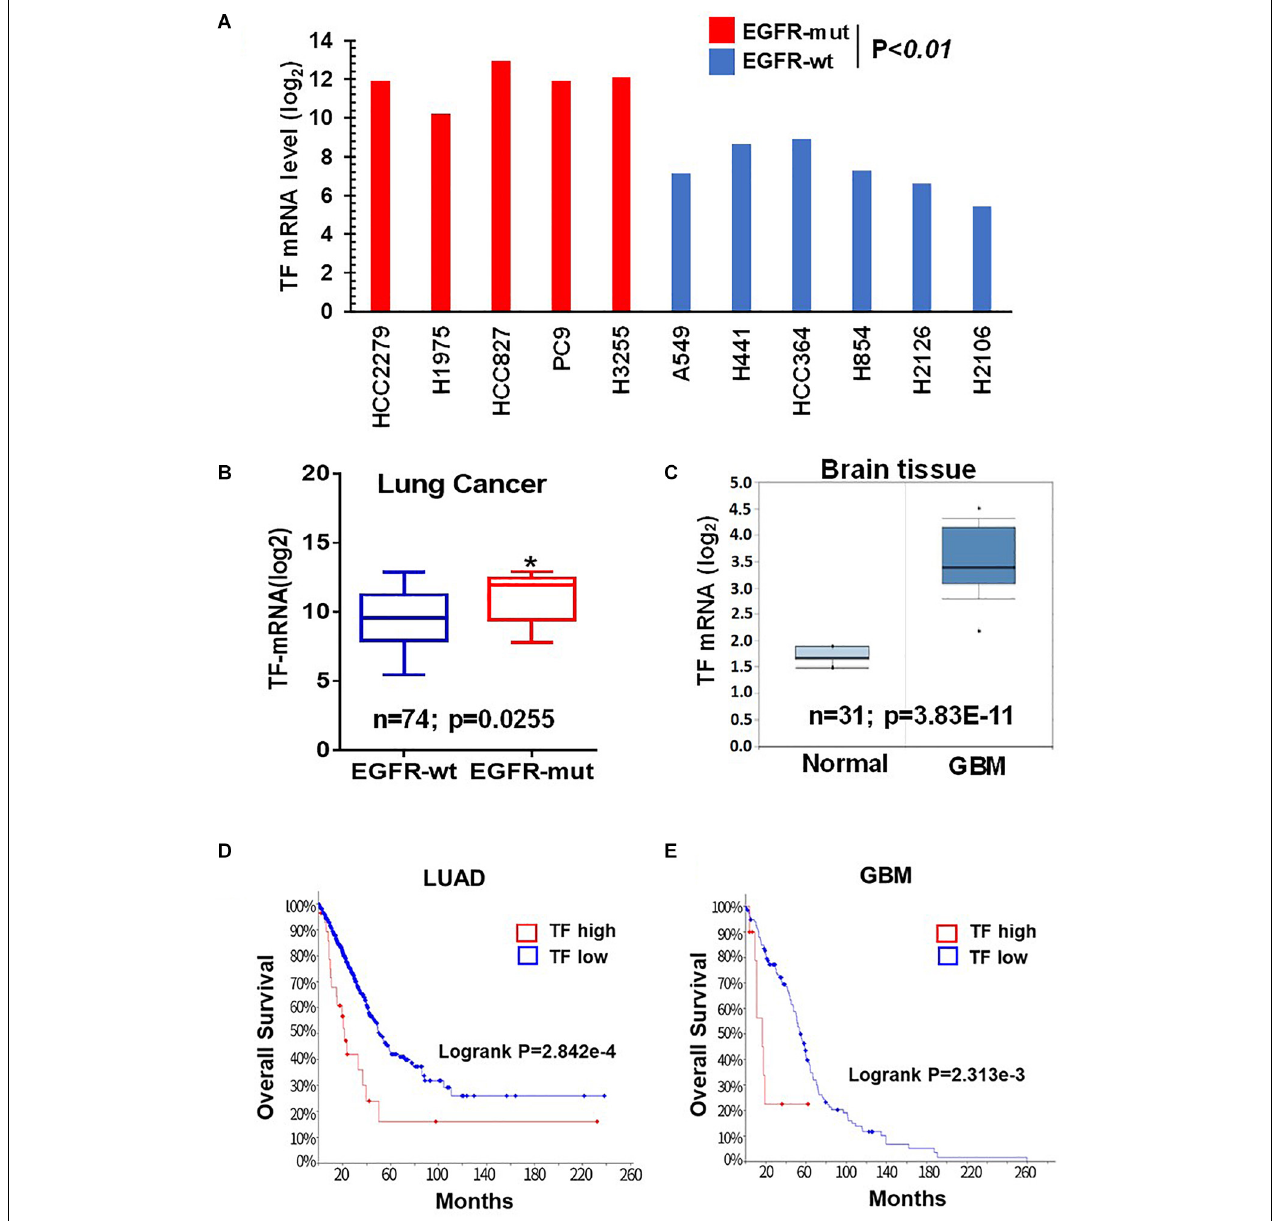
FIGURE 1 | Tissue factor (TF) is elevated in EGFR-mutant NSCLC and GBM. (A) TF mRNA levels for EGFR-mut versus EGFR-wt NSCLC cell lines were analyzed from CCLE database. (B) TF mRNA levels for EGFR-mut versus EGFR-wt lung adenocarcinoma tumors were analyzed from TCGA (https://portal.gdc.cancer.gov; dataset accessed in September 2018). (C) TF mRNA levels for normal brain and GBM tissue were analyzed from Oncomine (https://www.oncomine.org; dataset accessed in 2017). (D,E) Overall survival rate (OS) was analyzed by using Kaplan-Meier on cBioportal (https://www.cbioportal.org; TCGA PanCancer Atlas dataset accessed in October 2019) for lung adenocarcinoma (D) and GBM (E) . * P <